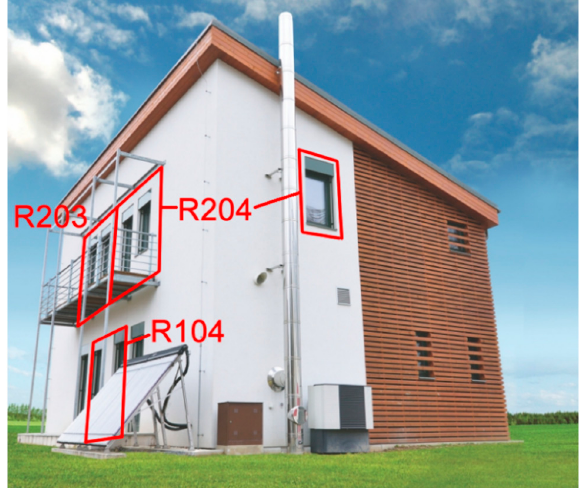
Figure 1. The wooden building of the passive standard located in the Faculty of Civil Engineering, VSB—TU Ostrava with selected smart home (SH) rooms R204, R203, and R104 [15].